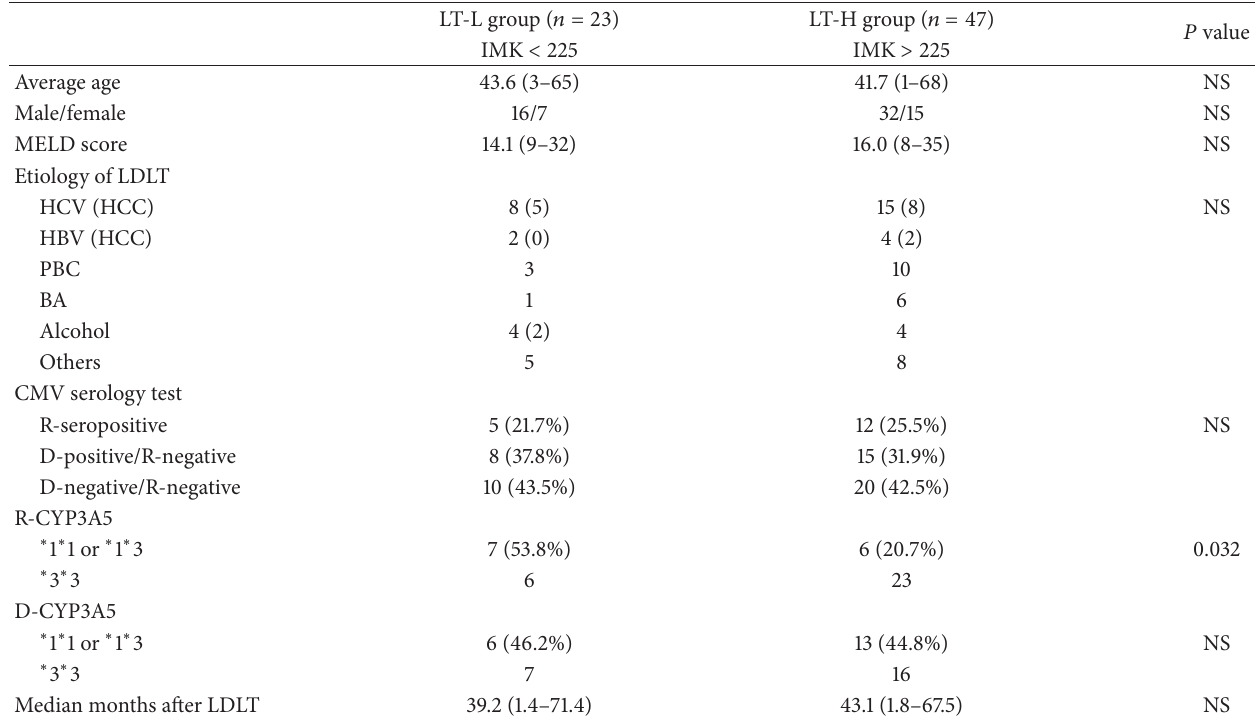
Table 1: Backgrounds of LDLT